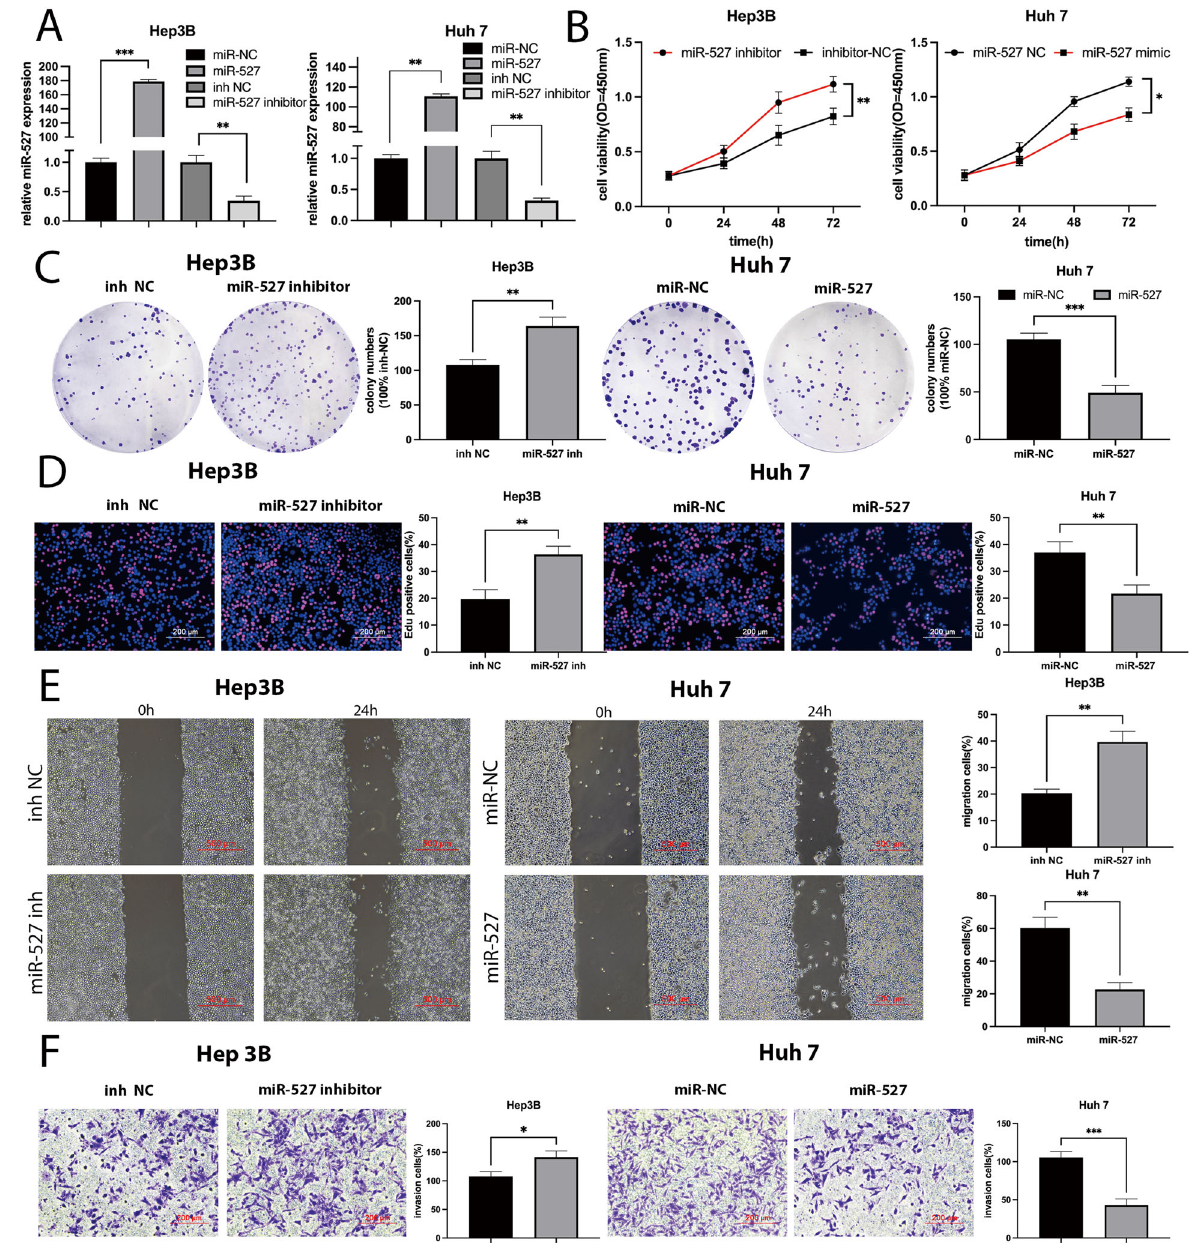
Fig. 4 MiR-527 inhibits HCC progression. A Relative miR-527 expression of HCC cells transfected with miR-527 mimics or corresponding negative controls (miR-NC) and miR-527 inhibitors or corresponding negative controls (inh-NC) according to qRT-PCR. B MiR-527 signi fi cantly inhibited the cell growth while miR-527 inhibitors promoted HCC cell growth as determined by CCK-8 assays. C MiR-527 signi fi cantly inhibited the colony formation, while miR-527 inhibitors exerted the opposite effect on colony formation. D EdU assays showed that miR-527 signi fi cantly suppressed DNA synthesis, while miR-527 inhibitors exerted the opposite effect on the HCC cell DNA synthesis. E Wound-healing assays were used to compare the migration abilities of Hep3B and Huh7 cells transfected with inh-NC or miR-527 inhibitors and miR-NC or miR-527 mimics. F The effect of miR-527 on HCC cell invasion abilities was determined by Transwell assays. MiR-527, miR-527 mimics for miR- 527 overexpression system; miR-NC, negative control plasmids relative to miR-527 mimics; miR-527 inh, miR-527 inhibitors; inh-NC, relatively control plasmids of miR-527 inhibitors. All values are presented as mean ± SD from three independent experiments with similar results. (* p < 0.05, ** p < 0.01, *** p < 0.001).